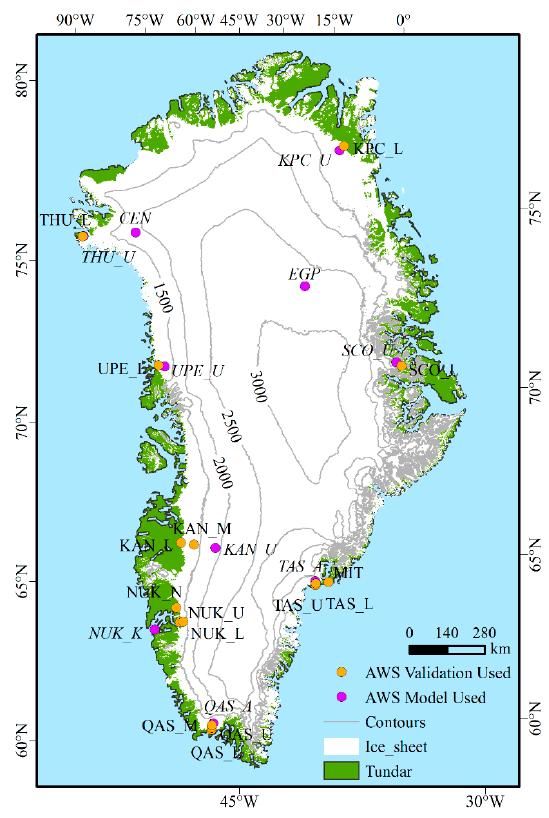
Figure 1. Overview map of the study area. The purple circles are training data set stations (marked in italics), and the orange circles are validation data set stations.